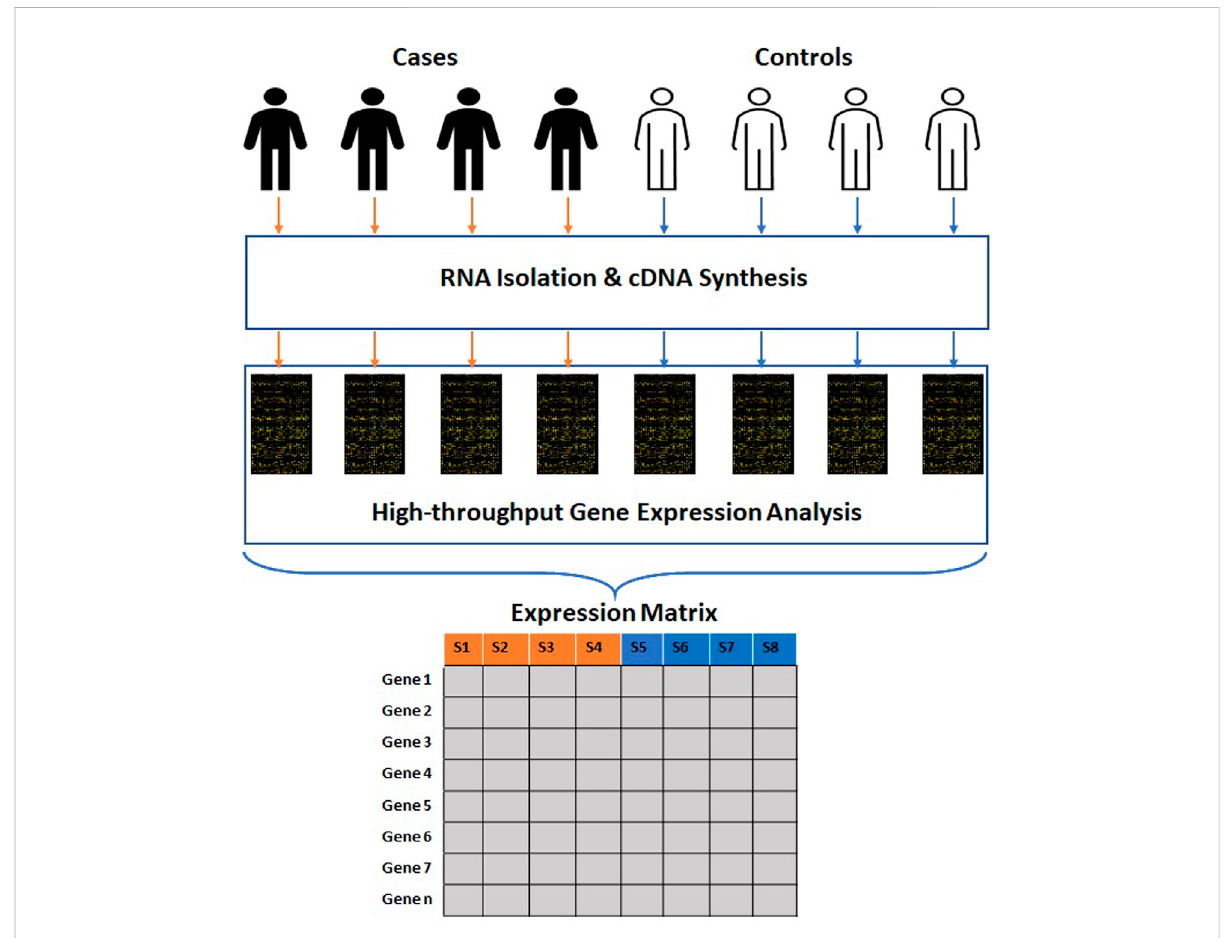
FIGURE 1 Process of generation of high-throughput gene expression data. The clinical samples are subjected to RNA isolation and cDNA synthesis. The cDNAsaresubjectedtohigh-throughputgeneexpressionanalysis.Therawdataobtainedfromthesemethodsisfurthertransmutedintoanumerical matrix where rows and columns represent genes and